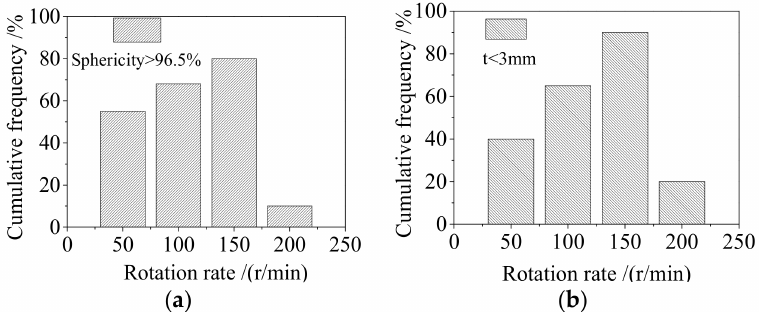
Figure 13. E ff ect of the rotation rate on the sphericity and thickness uniformity of the microspheres.